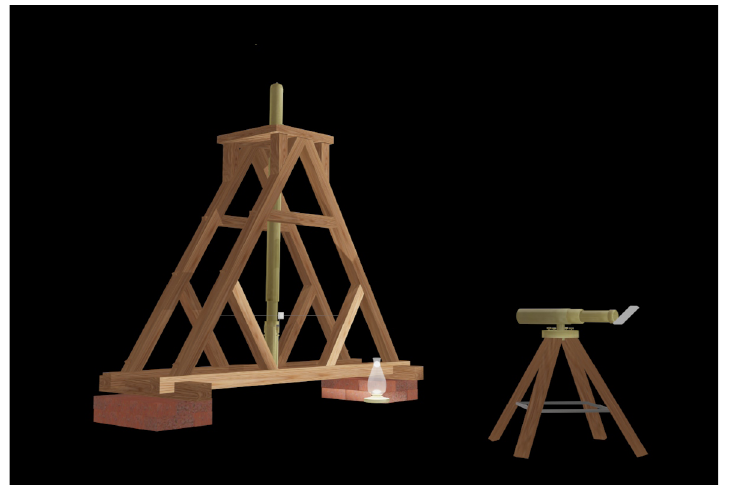
Figure 13. The Peirce No. 1 pendulum suspended in its